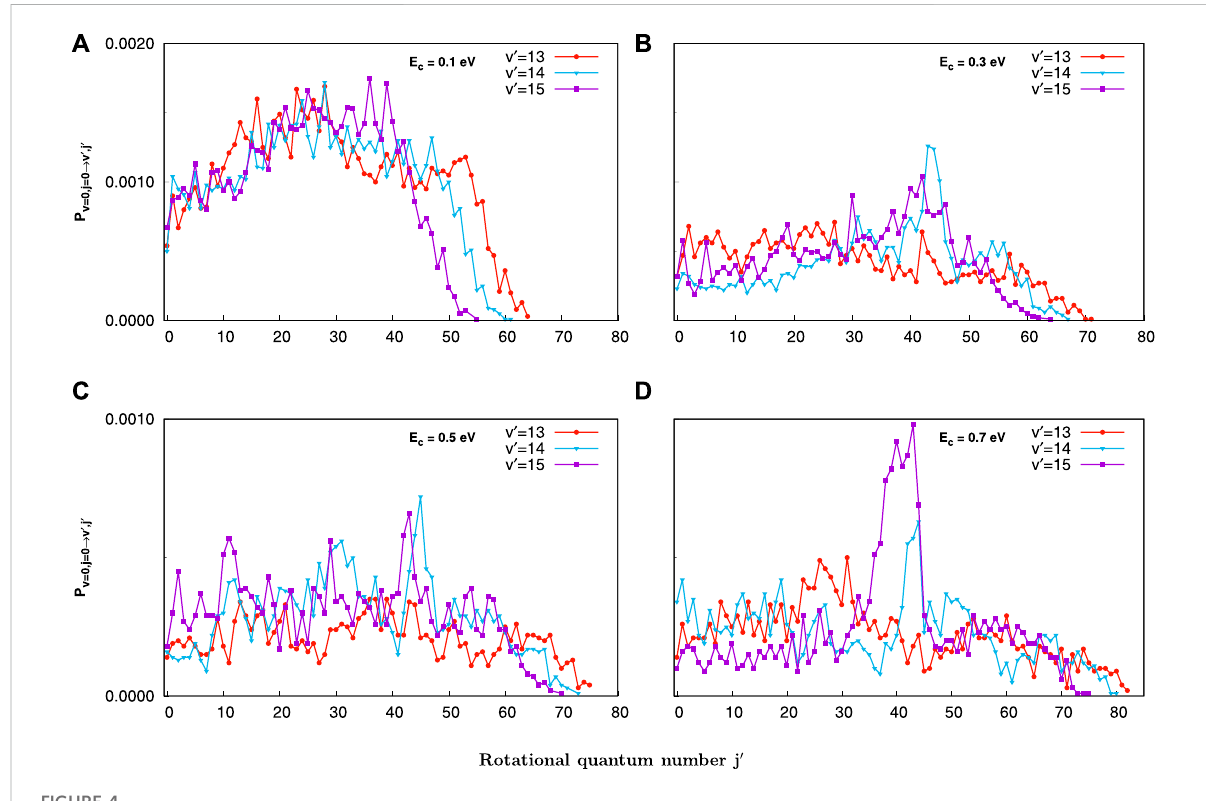
FIGURE 4 Final j ′ state-resolved reaction probabilities at J = 0 for the C + + SH( v = 0, j = 0) → H + CS + ( v ′ = 13, 14, 15) reaction at selected collision energies (0.1, 0.3, 0.5, and 0.7 eV) obtained with the QCT method. (A) for 0.1 eV, (B) for 0.3 eV, (C) for 0.5 eV, (D) for 0.7